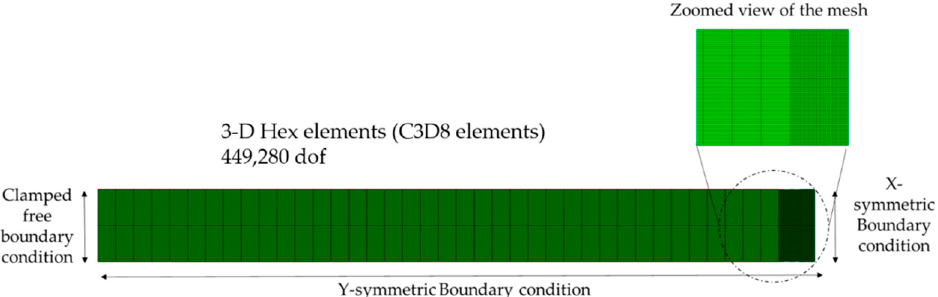
Figure 2. Finite element configuration of the model exhibiting the applied axis-symmetric boundary conditions and the mesh configuration.